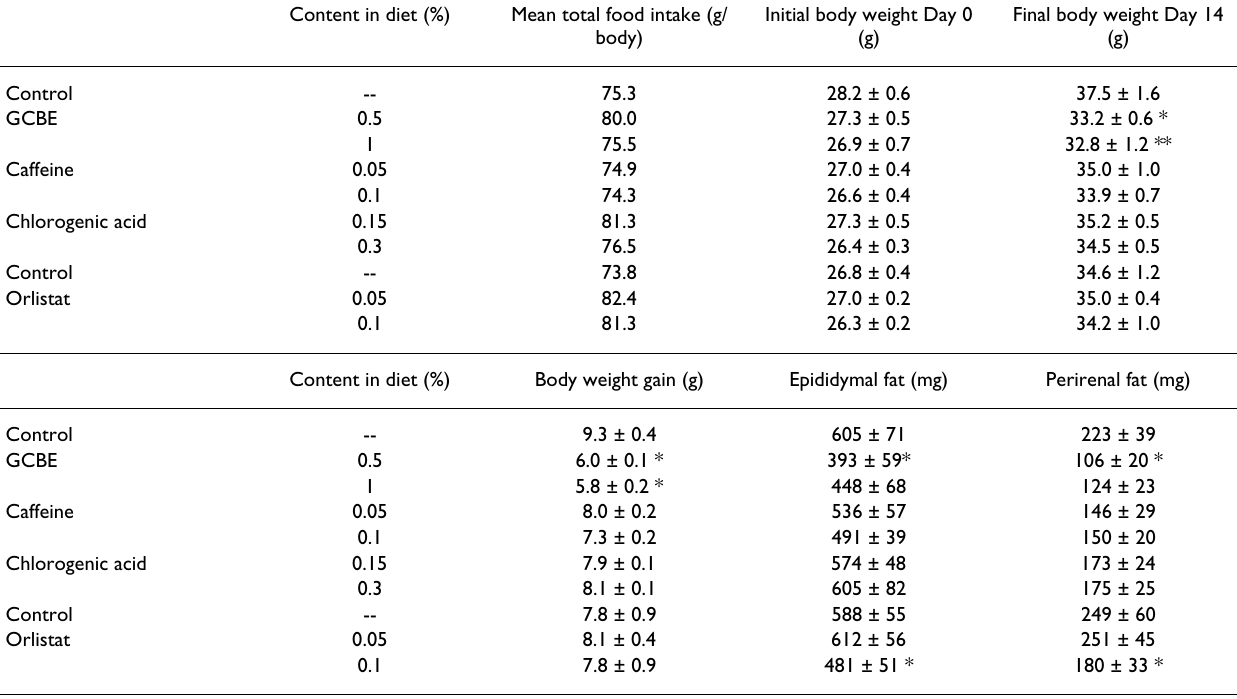
Table 1: Effects of GCBE and its constituents on body weight gain and accumulation of visceral